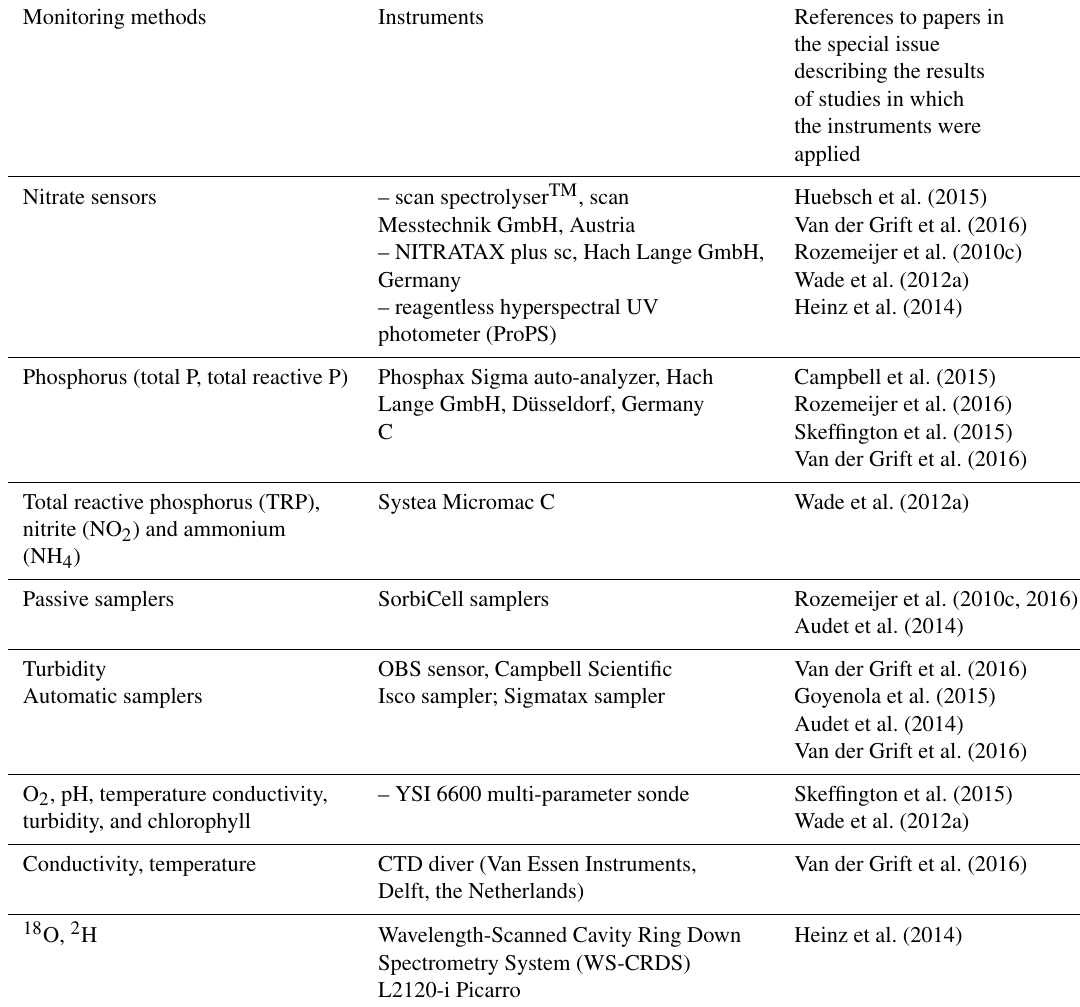
Table 2. Overview of monitoring methods and instruments applied in the session abstracts and special issue